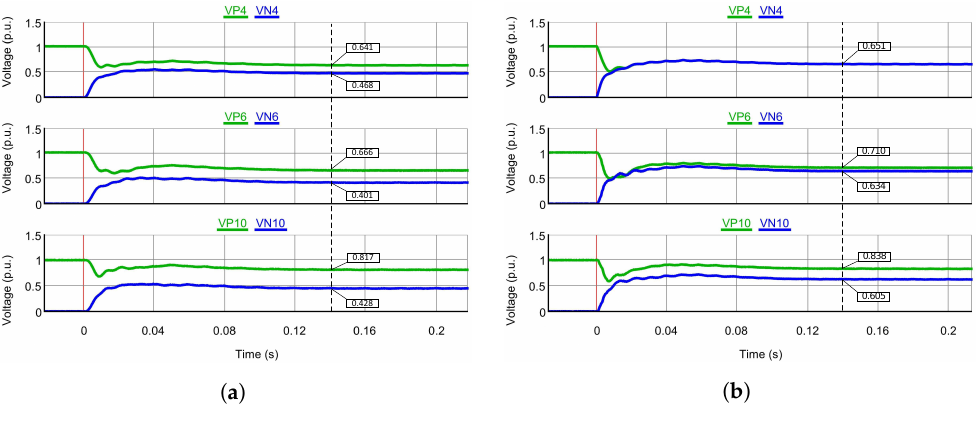
Figure 6. Sequence voltages from the RTDS simulation of a fault at bus 4: ( a ) S3, A–g fault. ( b ) S4, A–B fault. (VP: positive-sequence voltage; VN: negative-sequence voltage; the number refers to the bus number).